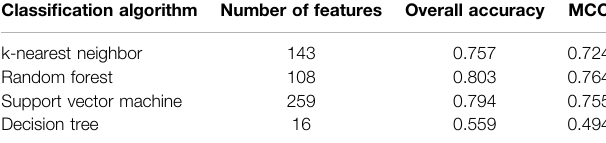
TABLE 3 | Performance of the optimum models using PseAAC